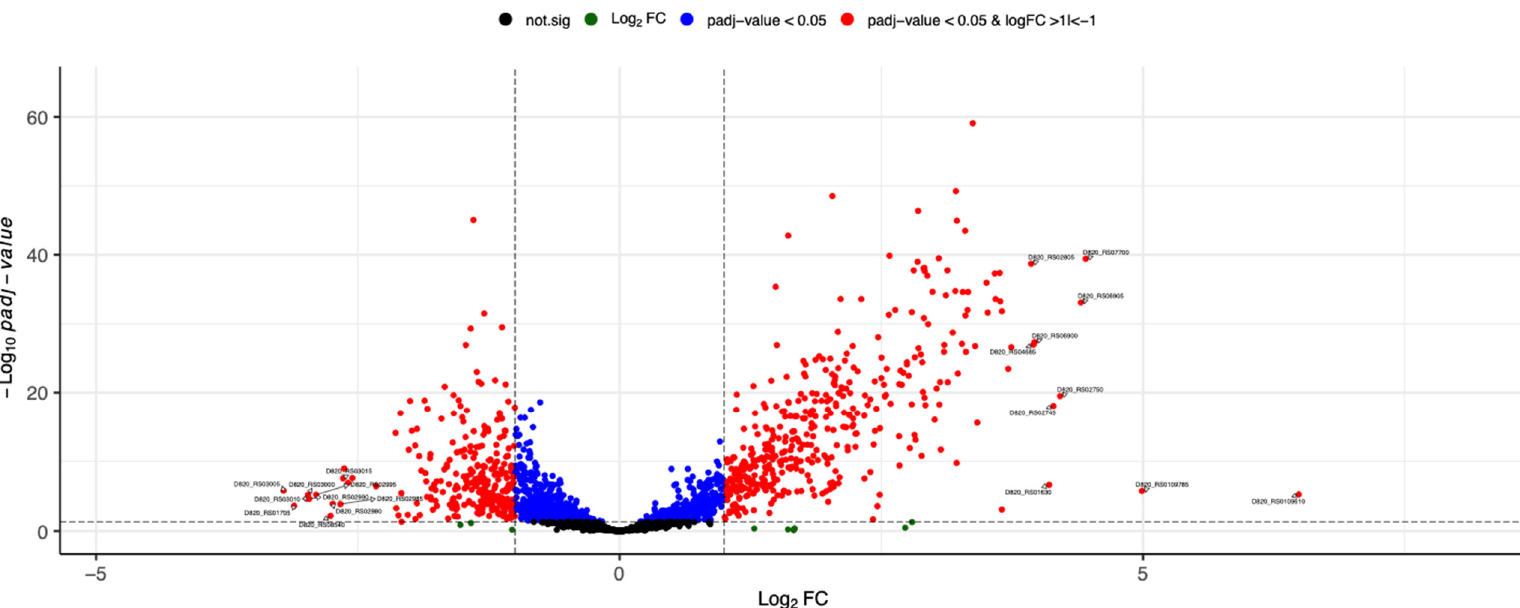
Figure 2. Volcano plot of differential gene expression of S. mutans treated with CHX versus untreated bacteria. Each point represents the average value of one transcript in five replicate experiments. The expression difference is considered significant for a multiple (FDR-based) adjusted p-value of 0.05 (light grey broken horizontal line). The list of DE genes was then further filtered for biological relevance by filtering on a log 2 fold change of ≥ 1 and ≤− 1 (red points, outer blue broken vertical lines). The top 20 DE genes based on log 2 fold change are labelled.